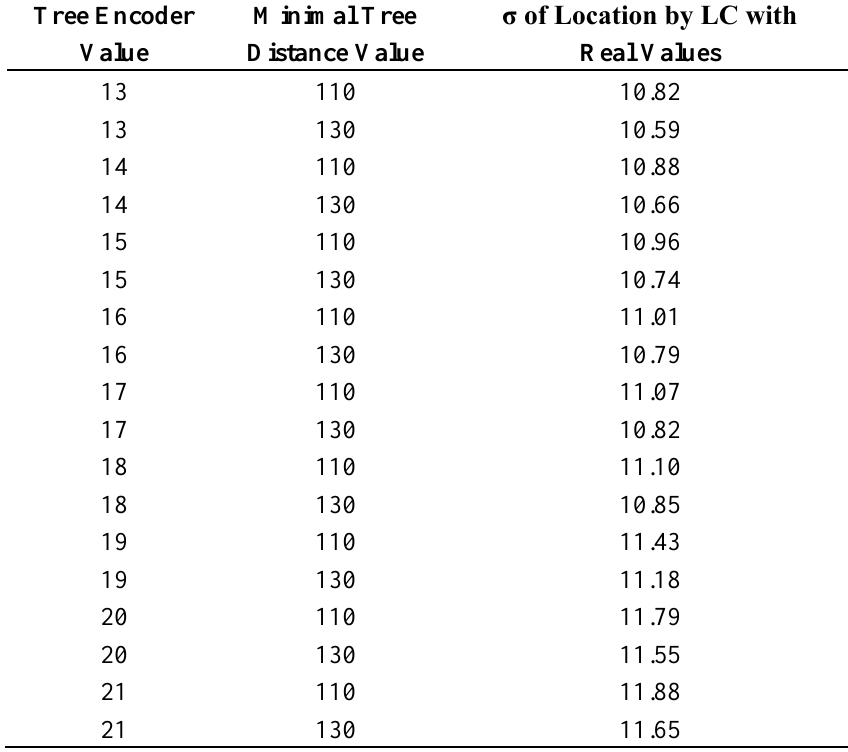
Table 4. Results obtained during the parameter evaluation with minimal number of trees not detected (4 total trees not detected for a total of 373